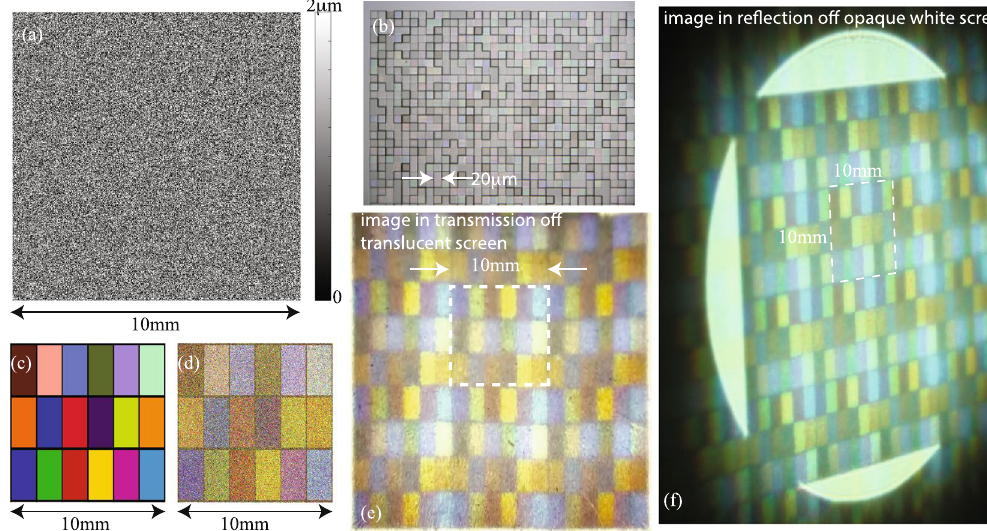
Figure 2. Hologram encoding a Macbeth color chart. ( a ) Design height map of the hologram. ( b ) Optical micrograph of a portion of the hologram. ( c ) Target image of the Macbeth chart. ( d ) Simulated image created by the hologram, when it is illuminated by the design wavelengths. ( e ) Photograph of the image on a white translucent screen taken in transmission at normal viewing angle. ( f ) Photograph of the image reflected of a white opaque screen taken at an oblique viewing angle. Note that the color image does not change with viewing angle (also see Figs S10 and S11). Illumination is full white spectrum from super-continuum source for both ( e ) and ( f